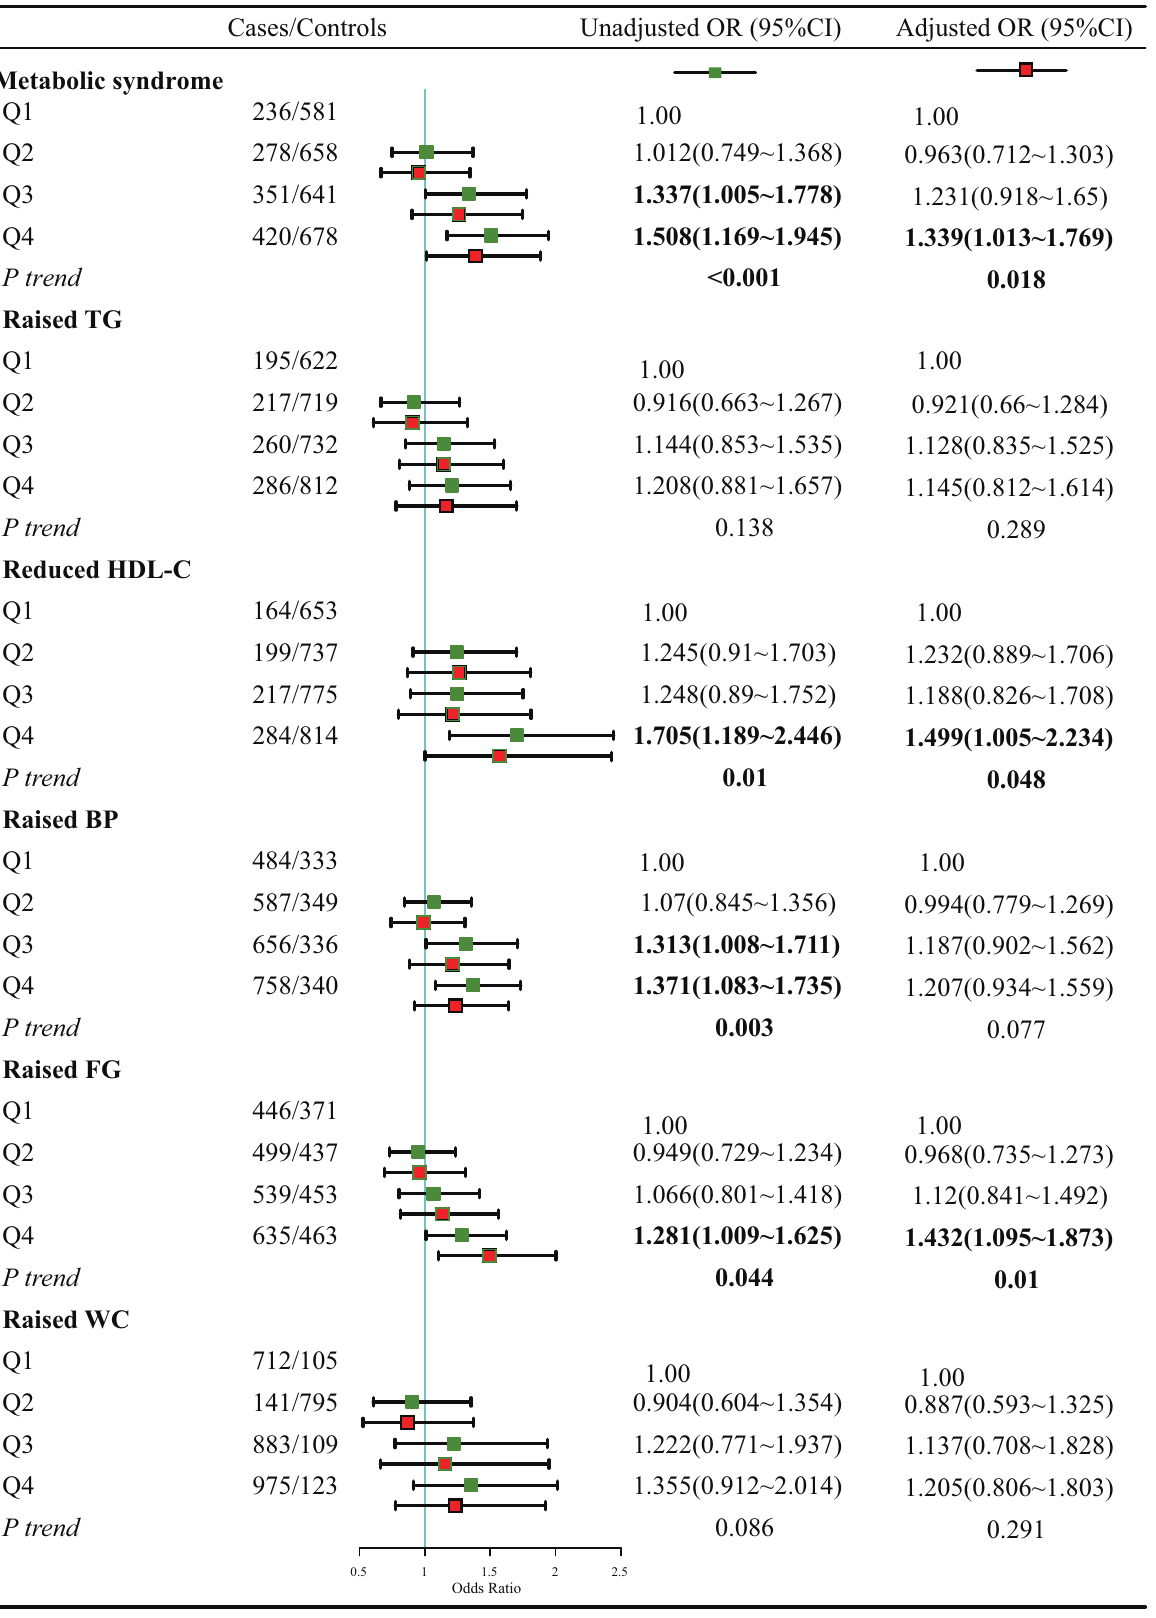
Figure 2. Association of DII with MetS and its components. Adjusted for confounding factors such as age, gender, race, education, poverty–income ratio, smoking, alcohol consumption, and sedentary